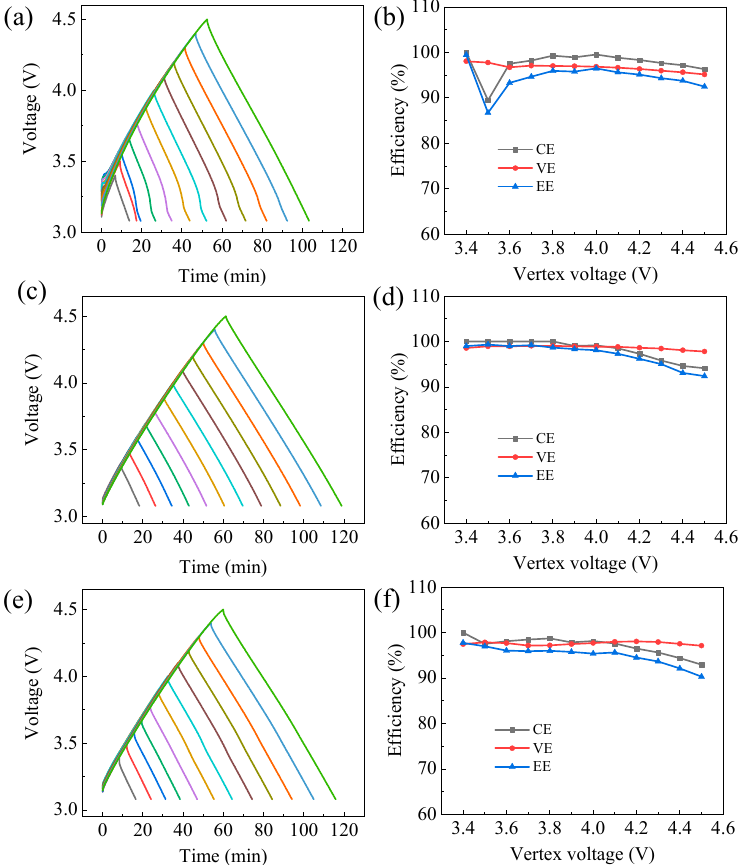
Figure 1. Galvanostatic charging and discharging curves of AC//Li half-cells upon the voltage ranges from pzc to various vertex voltages in different Li-ion electrolytes: ( a ) EDD, ( c ) EPD, and ( e ) PCE; the corresponding EE, CE, and VE values as functions of the vertex voltage: ( b ) EDD, ( d ) EPD, and ( f ) PCE.